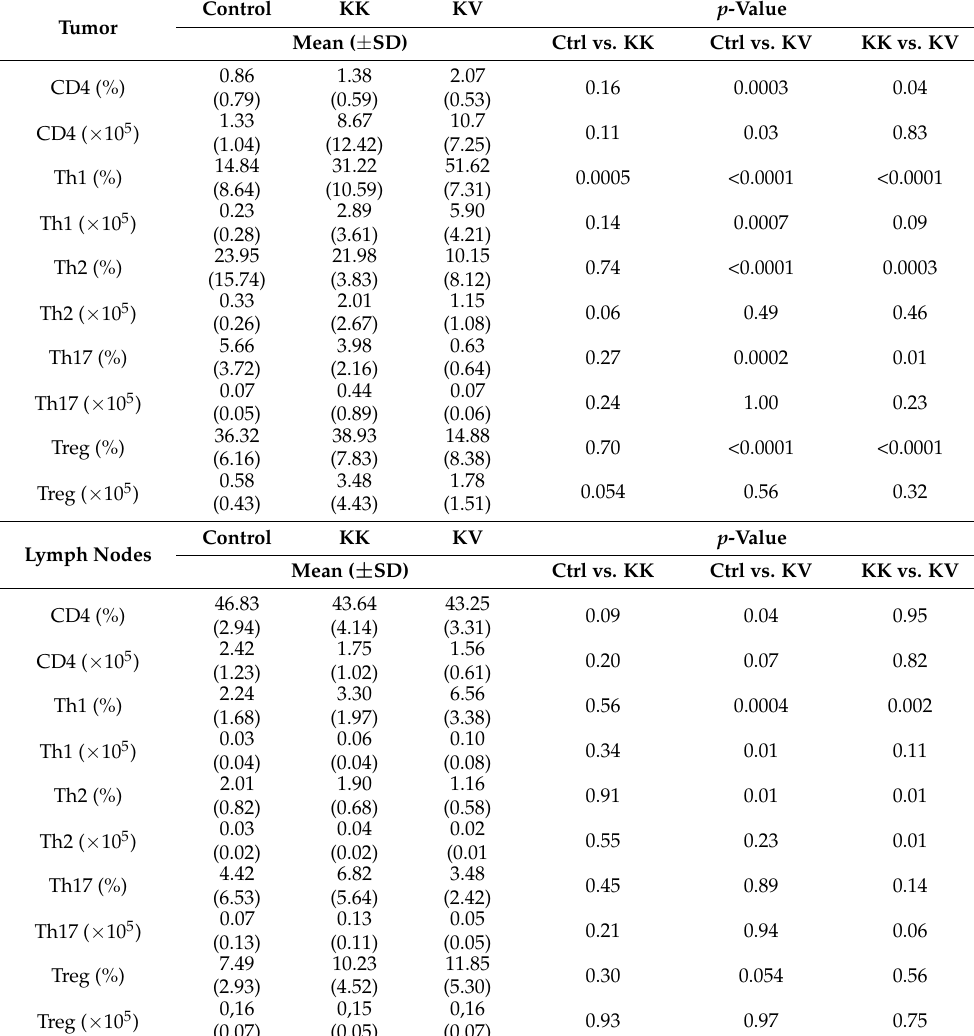
Table 1. CD4+ T cell % among CD45+ cells and Thelper subtype % among CD4+ T cells in the tumor or tumor-dLNs. Control KK KV p Tumor